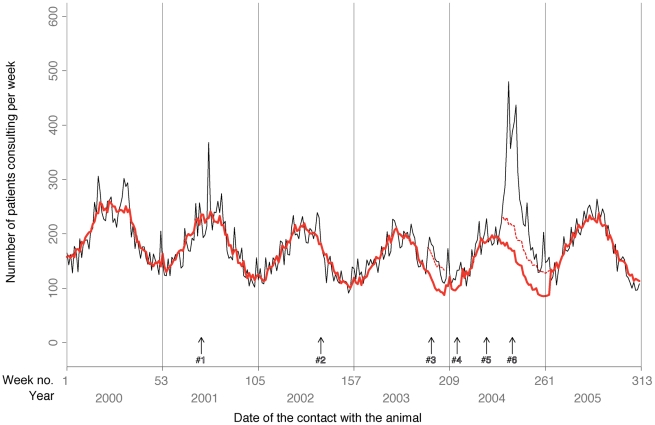
Weekly numbers of notified human contacts with animals that led to a consultation at an ARMC.This figure illustrates the behaviors associated with notified exposures at ARMC (n = 56,446). The model combines a forecasting ARIMA model for 2000–2004. Events #1, #2, #4, #5 and #6 correspond to illegal importations of rabid dogs from Morocco, while event #3 was an imported human case from Gabon. Event #1 could not been analyzed because the duration of observations preceding the event was too short to implement ARIMA modeling. The solid black line traces patients' ARMC consultations; the thick red line corresponds to the step-by-step modeling prediction of those consultations; the dashed red lines for event #3 and #6 represent the upper 95% CI. Note the increased consultation rates for these events, especially #6.